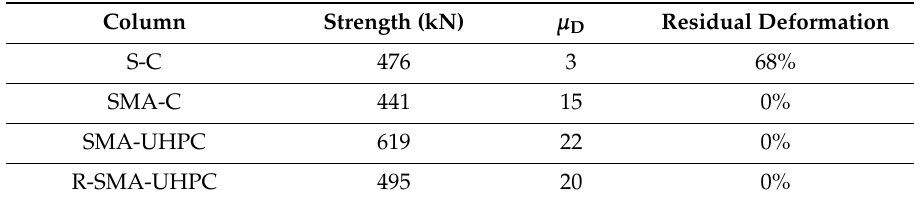
Table 2. Summary of the results.